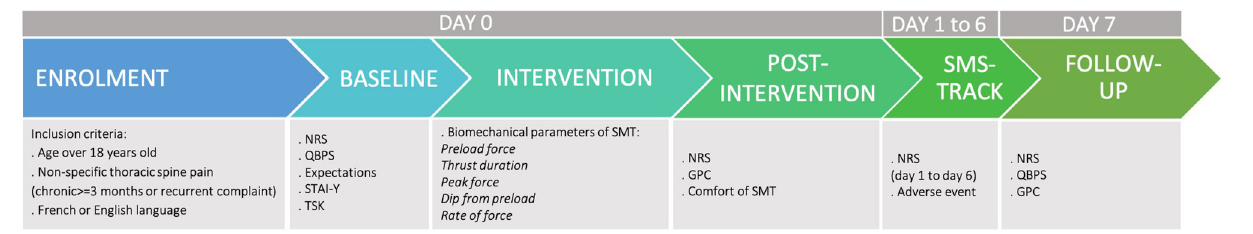
FIGURE 1 | Timeline of variables’ measurement. NRS = Numeric Rating Scale; QBPS = Quebec Back Pain Scale; STAI-Y = State-Trait Inventory Questionnaire; TSK = Tampa Scale of Kinesophobia; GPC = Global Perceived